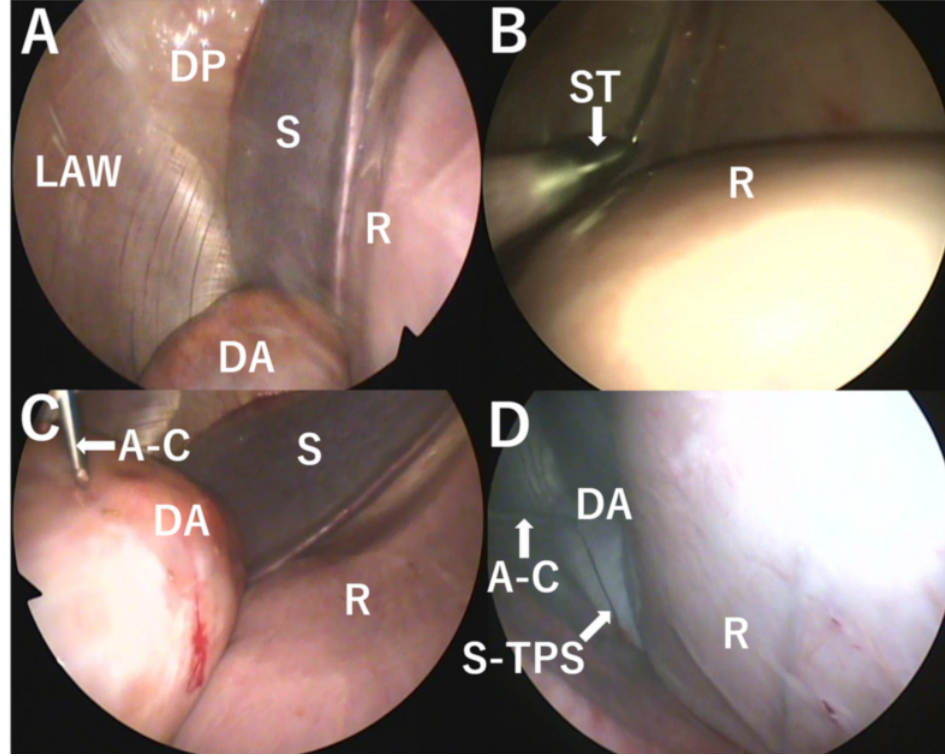
Figure 1. Laparoscopic views showing the cranial left abdominal cavity from an endoscope passing through a first trocar. ( A ) The displaced abomasum (DA) is seen in the space between the left abdominal wall (LAW) and the rumen (R). S: spleen; DP: diaphragm. ( B ) The apex of a second trocar (ST) is seen in the left abdominal cavity when being introduced into the 11th and 12th intercostal spaces. R: rumen. ( C ) The apex of a cannula (A–C) is advanced toward the DA while being inserted through the ST. S: spleen; R: rumen. ( D ) The suture part of a toggle–pin–suture (TPS) device